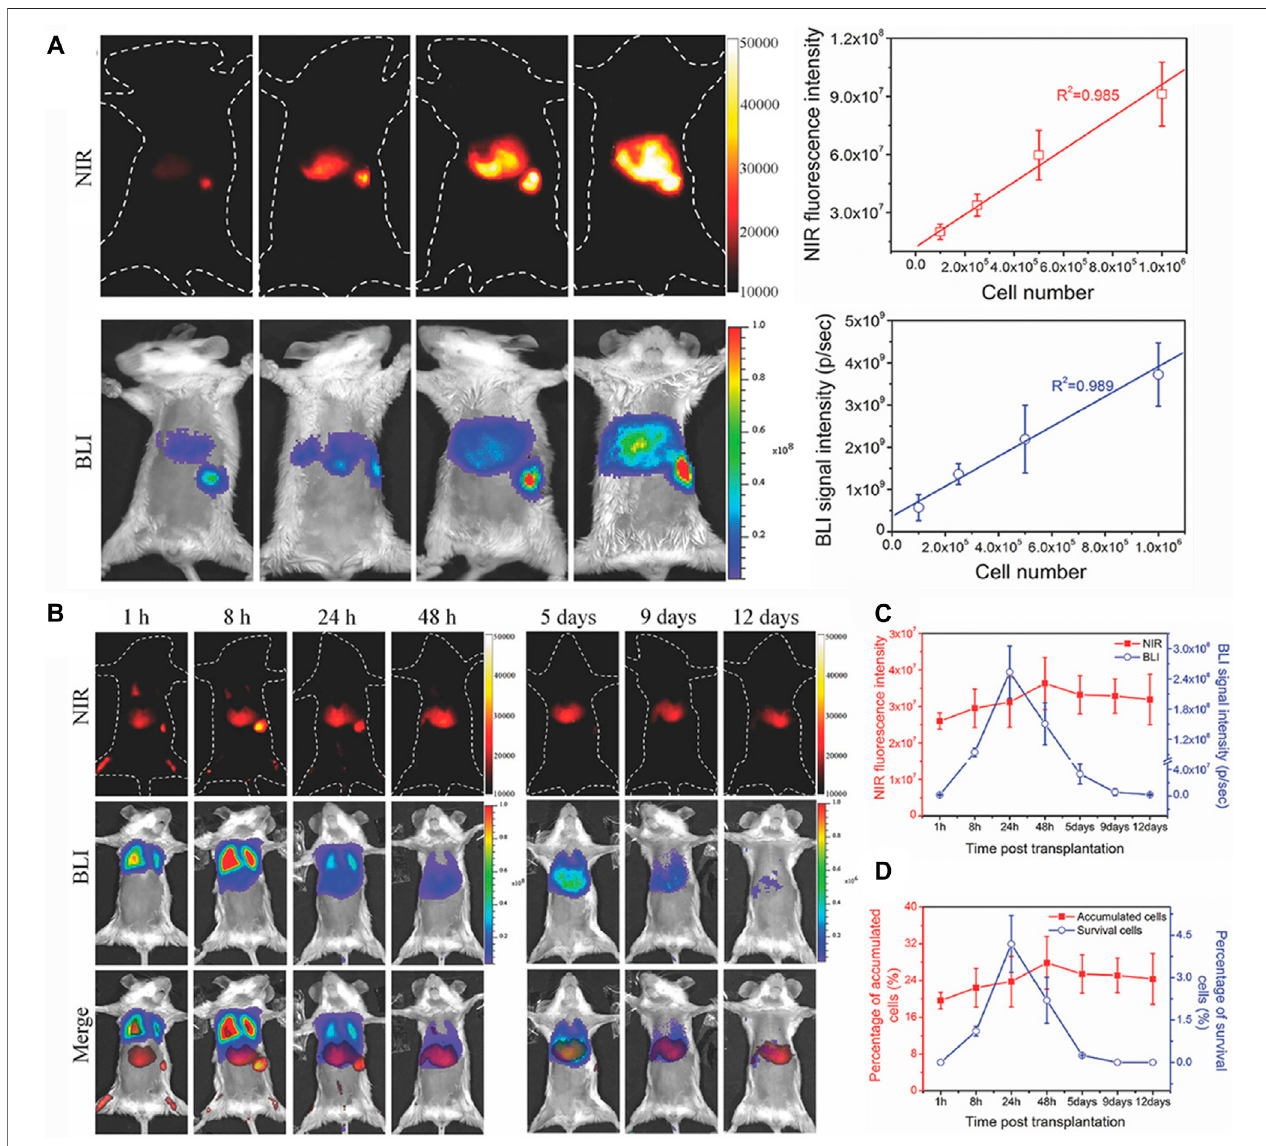
FIGURE 5 | In vivo quantitative analysis for cells fate. (A) In vivo imaging and quantifying of RfLuc and Tat-Ag 2 S QD dual-labeled mMSCs. NIR-II fl uorescence imagesand BLIimages ofdual-labeledmMSCs afterinjecting via thespleeninmice,and thelinearcorrelation ofthecellnumbers oftransplantedmMSCswiththeNIR-II fl uorescence intensities and BLI signals in liver and spleen. (B) In vivo tracking the fate of intravenously transplanted mMSCs for liver regeneration, NIR-II fl uorescence images, BLI images, and merged images of mice with acute liver failure. (C) Quantitative analyses of the cell accumulation and survival in liver by the total NIR fl uorescence intensities of NIRFI and the total photon fl ux (photons s − 1 ) of BLI. (D) Quantitative analyses of the accumulation and survival ratios of mMSCs in liver (reproduced from (Chen et al., 2018) with permission from WILEY-VCH Verlag GmbH and Co. KGaA, Weinheim).